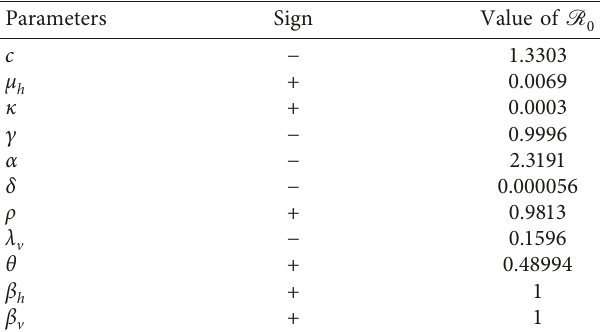
Table 3: R values with respect to model 0